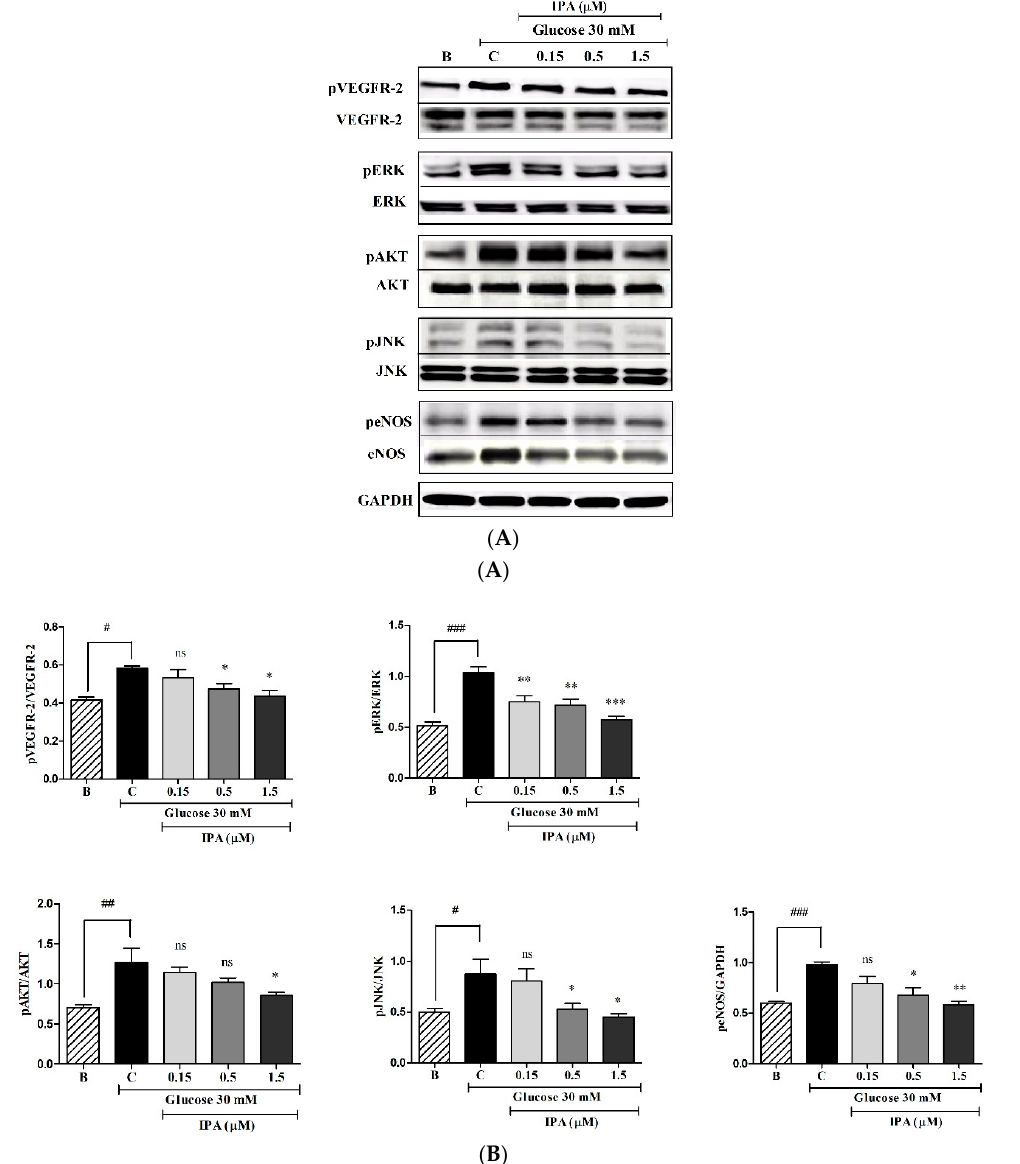
Figure 6. ( A ) IPA inhibits vascular endothelial growth factor receptor 2 (VEGFR-2) and its downstream signaling molecules. IPA attenuating high glucose-induced phosphorylation of VEGFR-2 and downstream signaling molecules extracellular signal-regulated kinase (ERK), protein kinase B (AKT), c-Jun N-terminal kinase (JNK), and endothelial nitric oxide synthase (eNOS) were detected using western blotting. ( B ) Quantitative evaluation of the protein expression. The effects of 30 mM glucose on the expression of each protein were compared to B (blank (0 mM glucose + 0 µM IPA)). The effects of IPA on high glucose-induced protein expression were normalized to C (control (30 mM glucose + 0 µM IPA)). ns; not significant, * p ˂ 0.05, ** p ˂ 0.01, *** p ˂ 0.001, # p ˂ 0.05, ## p ˂ 0.01, ### p ˂ 0.001.